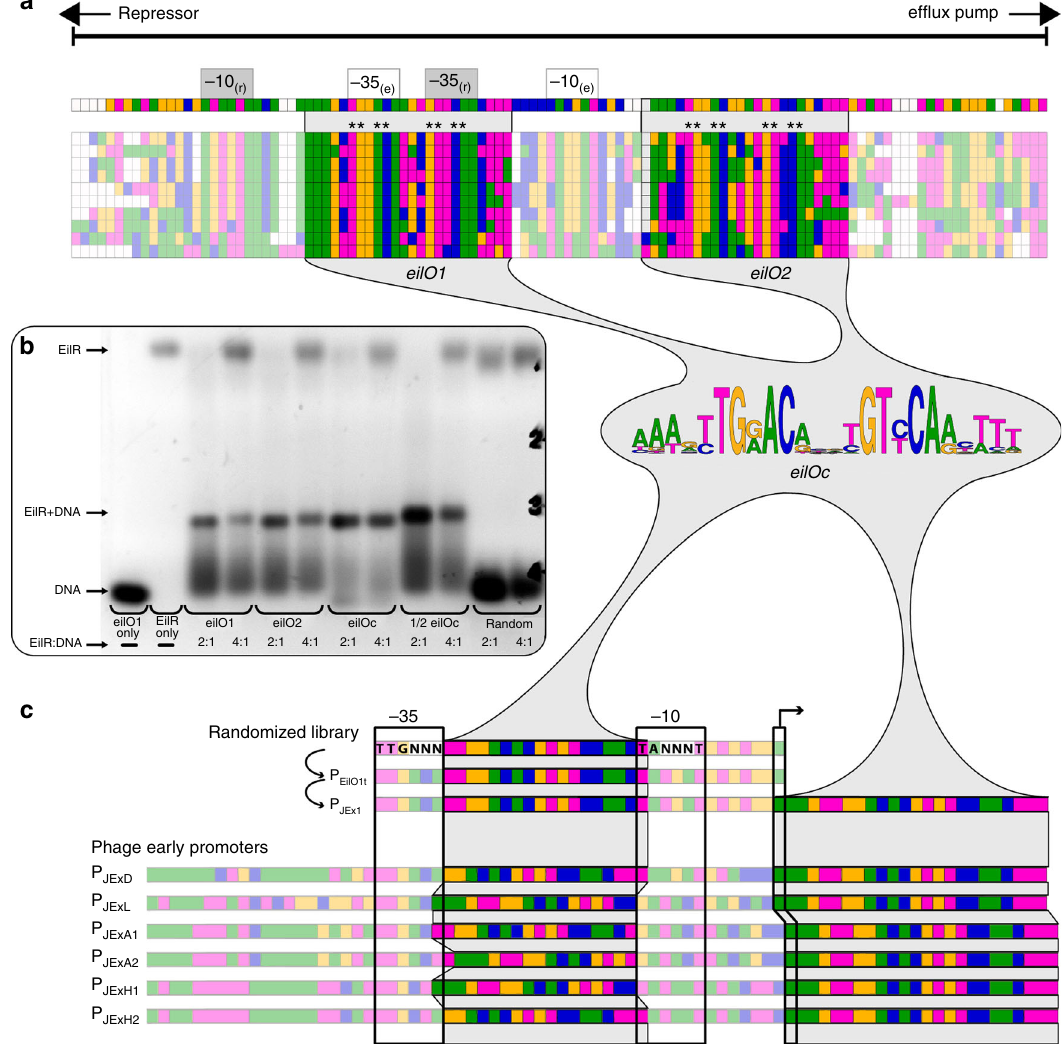
Fig. 1 EilR repressor-regulated promoter engineering. a Alignment of intergenic regions that separate the genes encoding ef fl ux pumps and their cognate repressors in gamma-proteobacteria homologous to the E. lignolyticus eilAR locus. All intergenic regions contain two repressor-binding sites eilO 1 and eilO 2 , from which the 24-bp consensus operator ( eilO c ) motif emerges. The asterisks indicate the base pairs conserved in all operators. Predicted promoter hexamers are shown for the repressor genes ( − 35 r , − 10 r ) and for the ef fl ux pumps ( − 35 e , − 10 e ). Each colored box represents a nucleotide: A (green); T (magenta); G (yellow); C (blue). b Electrophoretic mobility shift binding assays of puri fi ed EilR with the full-length native E. lignolyticus operators ( eilO 1 , eilO 2 ) , the full consensus operator ( eilO c ) , half consensus operator (½ eilO c ) and random DNA. Molar ratios of the 21.6 kDa EilR monomer and duplex DNA are indicated. c A library of randomized E. coli consensus promoter boxes fused with a truncated consensus operator generated the biosensor P EilO1t , into which an additional full-length eilOc was placed at the transcriptional start site to yield P JEx1 . Immediate-early coliphage-promoters P D/E20 (P JExD ) and P H207 (P JExH1 , P JExH2 ) from phage T5, P L (P JExL ) from phage lambda, and P A1 (P JExA1 , P JExA2 ) from phage T7, were reorganized by placing a truncated eilOc into the spacer region, partially overlapping the − 35 or the − 10 hexamers, followed by addition of a full-length consensus operator at the transcriptional start site. An arrow indicates the transcriptional start site. Colors of the nucleotides belonging to the eilO c -operator are highlighted and the promoter − 35 and − 10 hexamers are